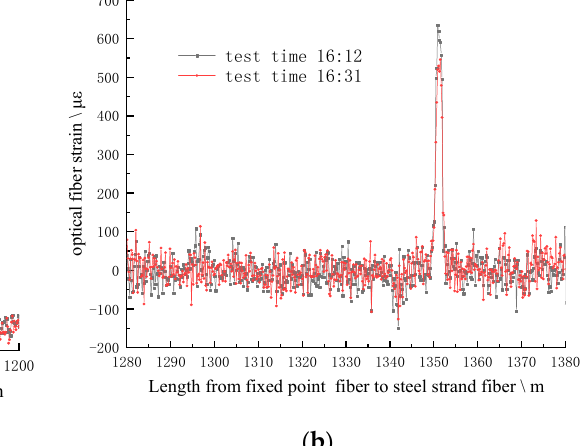
After half an hour of hot laying, strain test was conducted for the whole monitoring optical fiber line through BOTDR. Line ① and line ② are tested twice respectively. The strain curve of optical fiber is shown in Figure 24. Figure 23. Location calibration of downhole optical fiber hot deposition method.